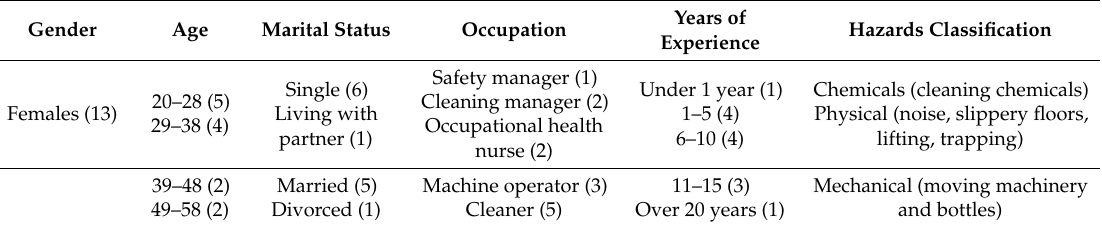
Table 3. Demographic characteristics of women in two beverage producing industries.